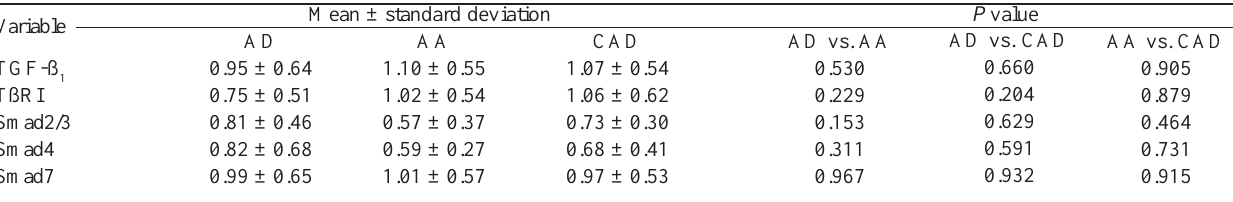
Table 2. Non-significance of relative net grayscales of Western blot assay by ANOVA